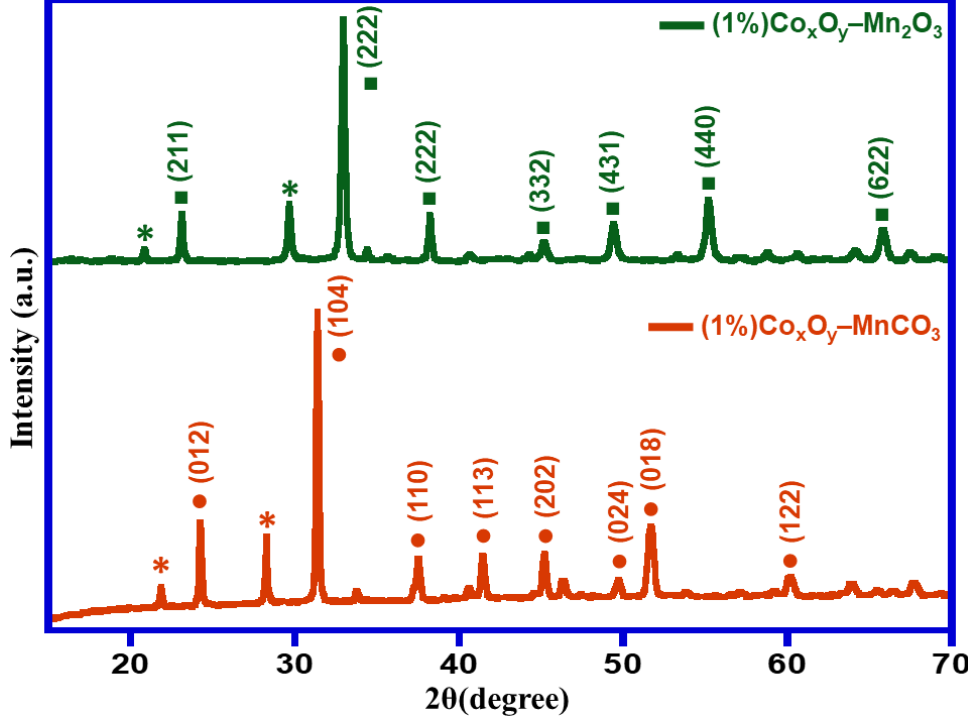
Figure 1. XRD diffractograms of the catalysts (1%)Co x O y –MnCO 3 calcined at 300 °C and (1%)Co x O y – Mn 2 O 3 calcined at 500 °C. Denotations of the symbols are as follows: ● MnCO 3 , ■ Mn 2 O 3. , and ⃰ unidentified